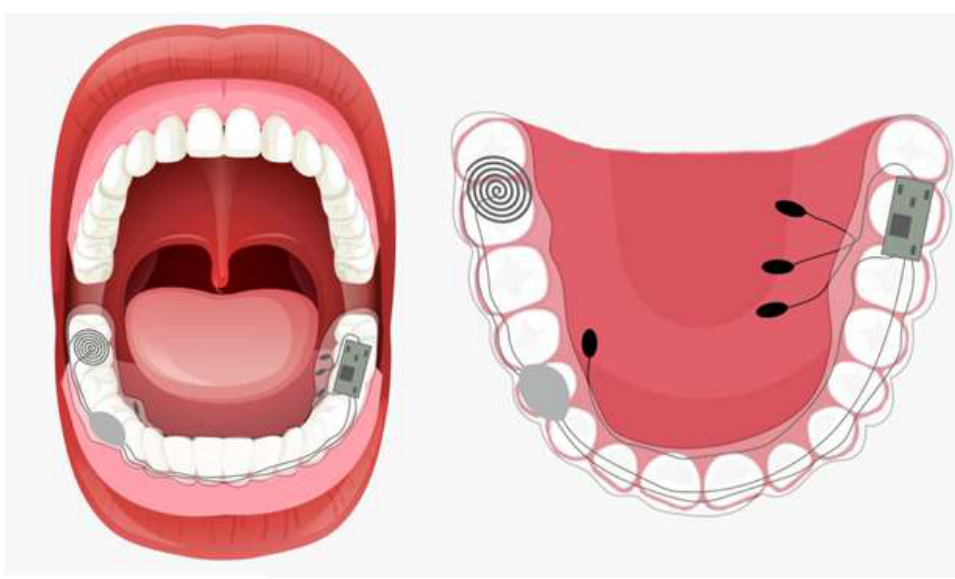
Figure 20. Design concept of the COPD mHealth device. On the left, illustration of how it would be inserted into the user ’ s mouth. On the right, illustration of the device, highlighting the placement of the surface and stimulus electrodes in contact with the genioglossus muscle.